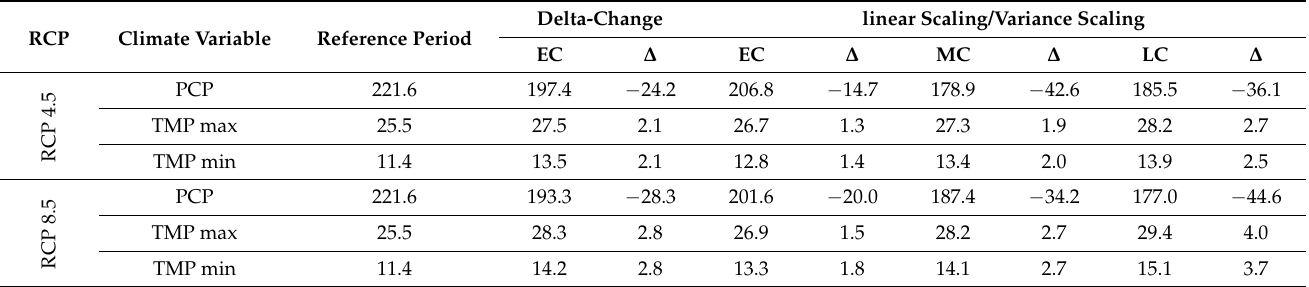
Table 6. Projected future scenarios mean annual values and change ( ∆ ) relative to the reference